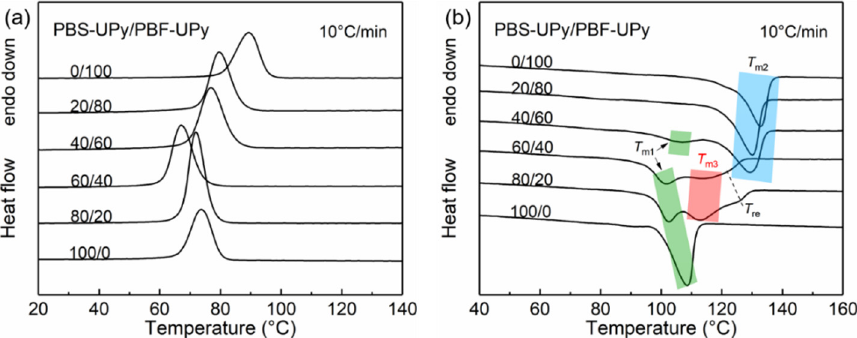
Figure 3. DSC curves of PBS ‐ UPy/PBF ‐ UPy blends during the melt ‐ cooling ( a ) and the subsequent heating ( b ) scans at a rate of 10 °C/min. heating ( b ) scans at a rate of 10 ◦